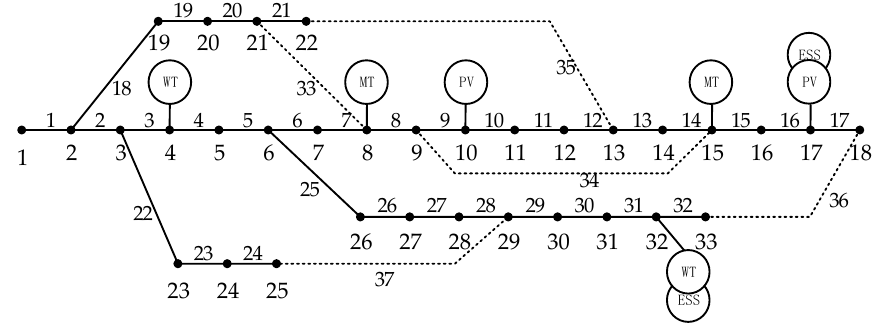
Figure 7. Network structure of modified IEEE 33-bus distribution system. WT: wind turbine; MT: microturbine; PV: photovoltaic.